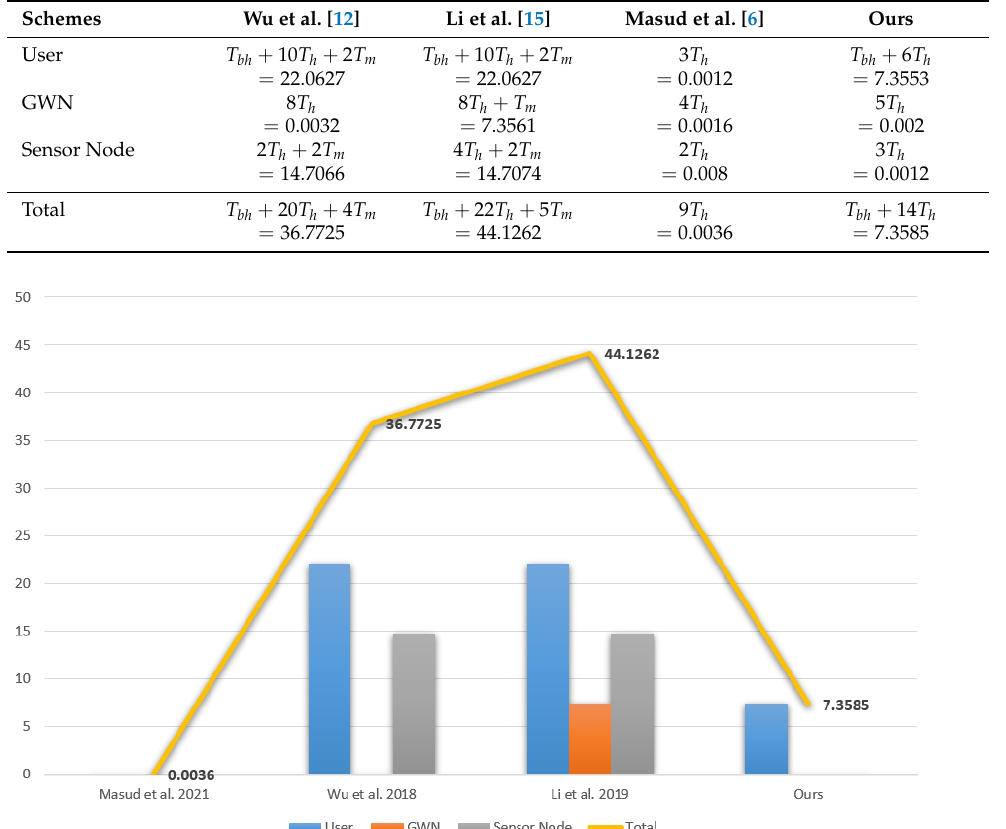
Table 13. Comparisons of computational cost.